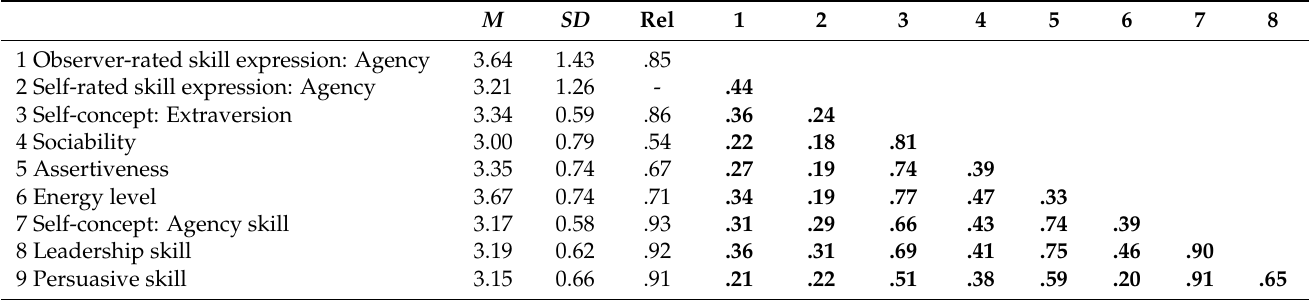
Table 3. Relationships of Skill Expression With Personality and Skill Self-Concepts: